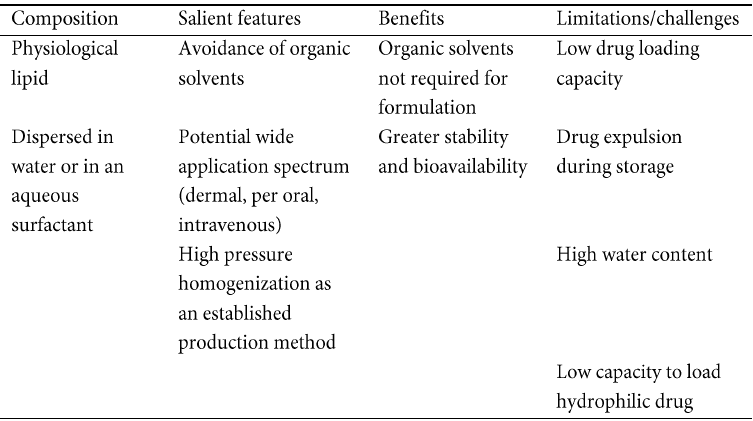
Table 3: Salient characteristics and limitations of